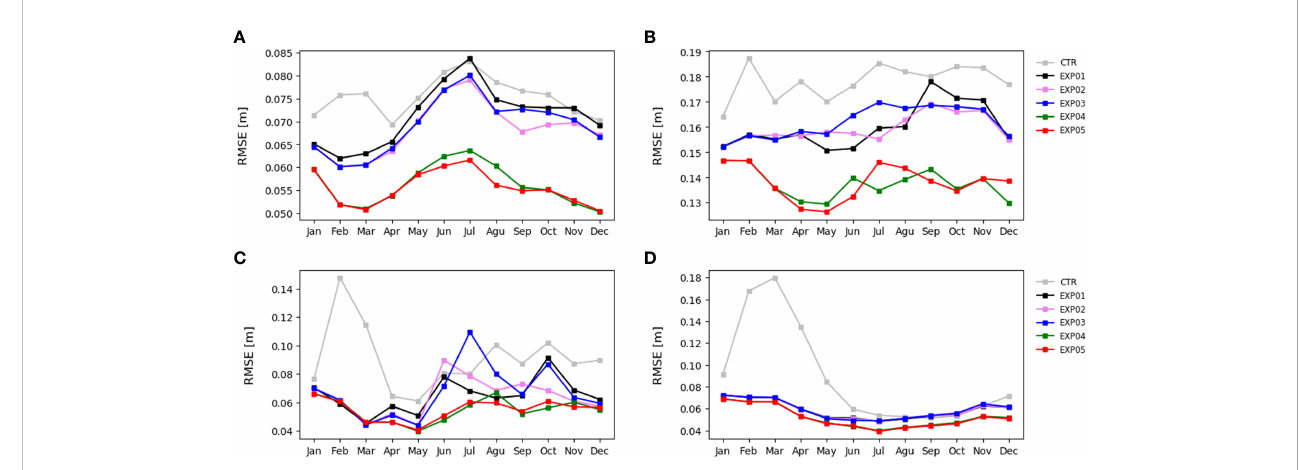
FIGURE 7 Monthly mean RMSE for sea surface height at the region of (A) Northwestern Paci fi c (NWP), (B) Kuroshio-Kuroshio extension (K-KE), (C) East/Japan Sea (EJS) and (D) Oyashio Current (OYC). Gray, black, violet, blue, green and red lines denote CTR and EXP01-05,